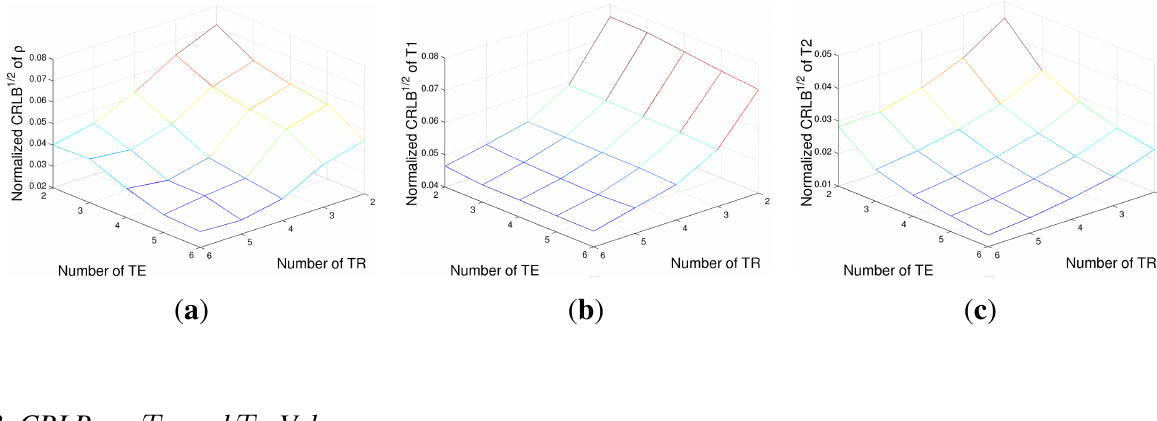
relaxation time ( b ) and 1